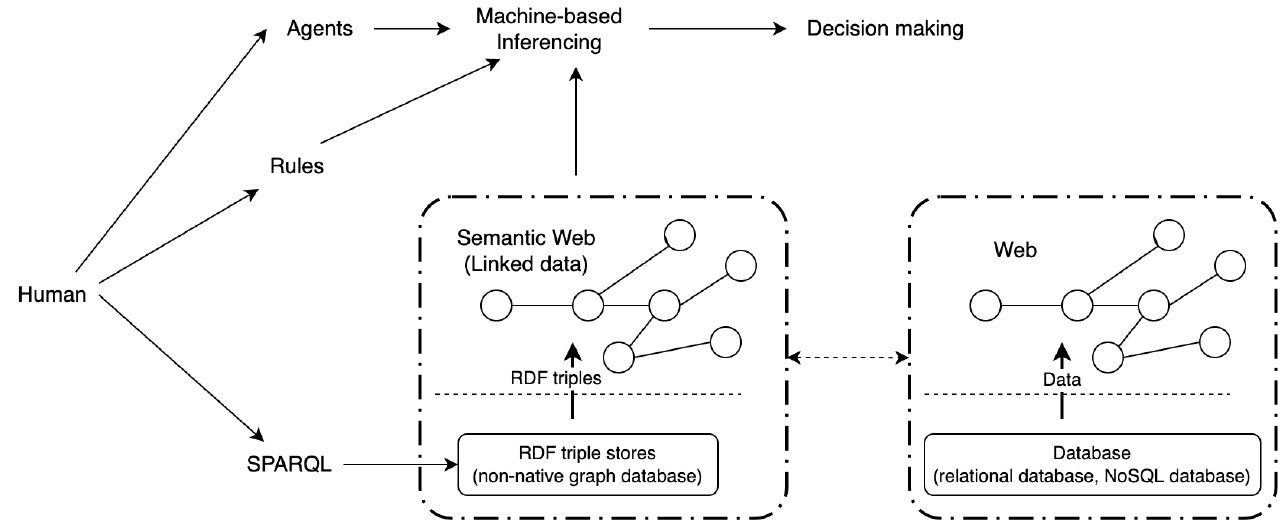
Figure 10. Relationship among humans, machine (agent), RDF, rules, Semantic Web, and Linked Data.